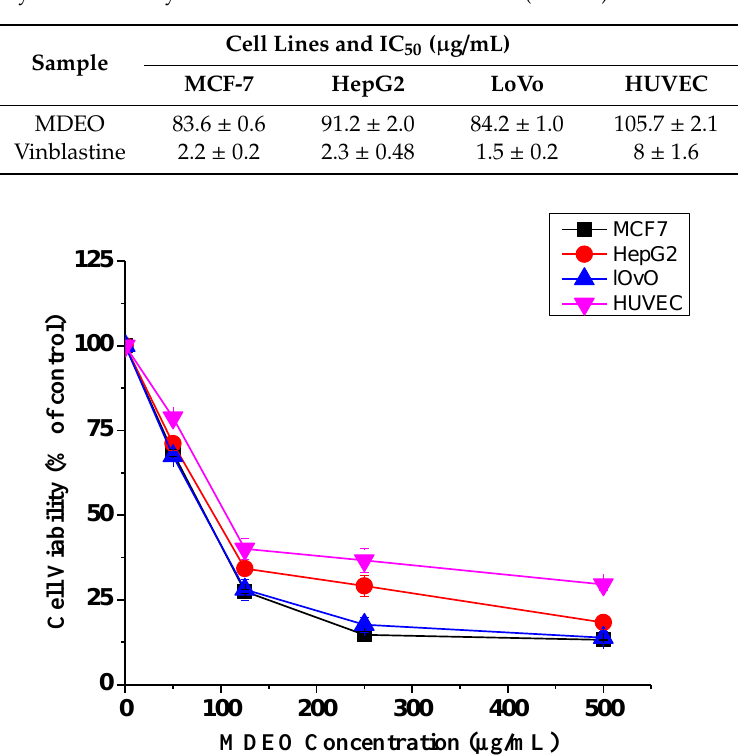
Figure 2. Cytotoxic effect of MDEO on different cancer cells. Dose-dependent curves treatment in MCF-7 (breast cancer), HepG2, LoVo (colon cancer), and human umbilical vein endothelial cell line (HUVEC) cells. Cells were cultured in 24-well plates and treated with different concentrations (50–500 µg/mL) for 48 h. Cell viability was measured by MTT assay. Data represent the mean ± S.D of three independent experiments carried out in triplicates.